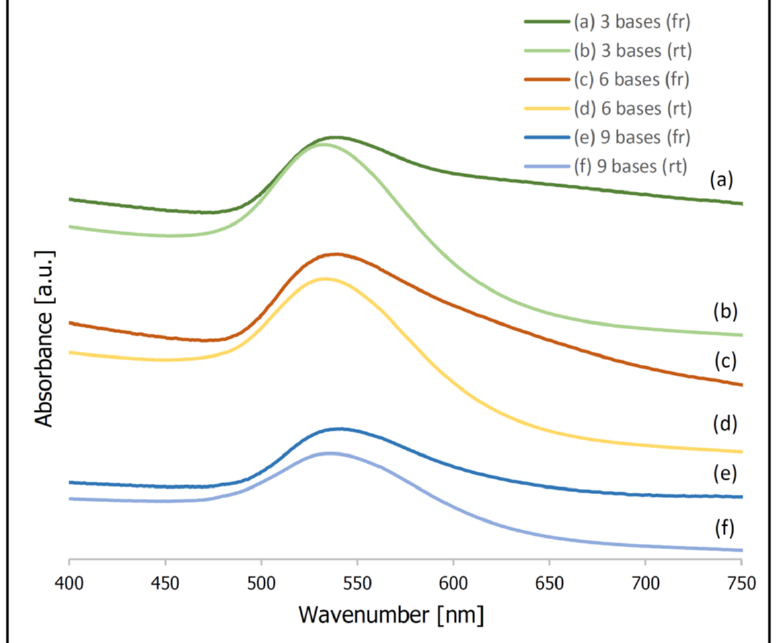
Figure 3. Normalized UV-Vis spectra of gold nanoparticles covered with thiolated DNA. The adsorption of DNA was carried out using a freezing step (spectra ( a , c , e )) and at room temperature (spectra ( b , d , f )). Experiments for: ( a , b ) 3 bases; ( c , d ) 6 bases; ( e , f ) 9 bases.